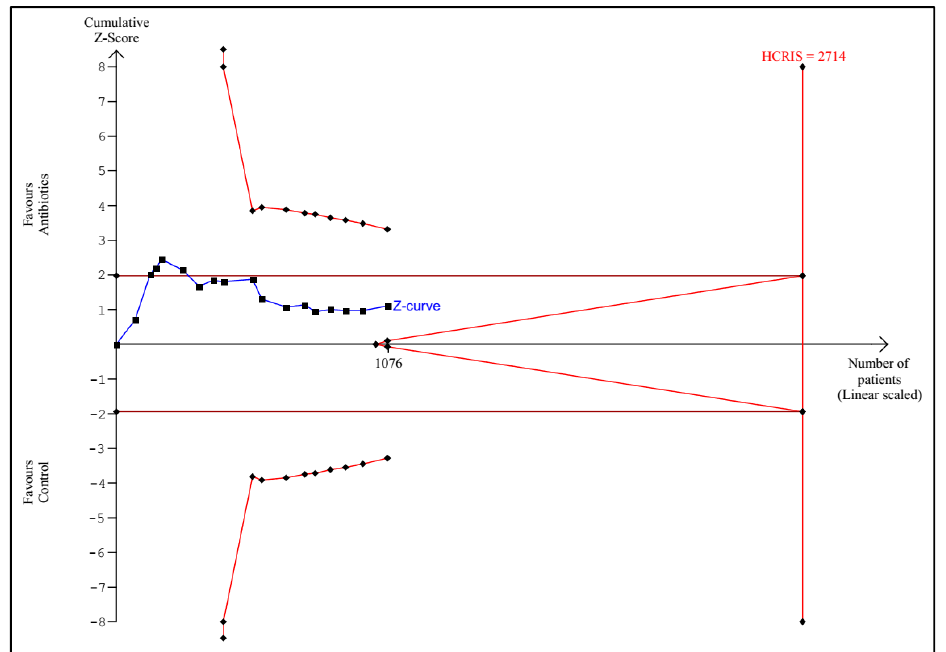
Figure 6. Trial sequential analysis for mortality. The cumulative Z-curve did not cross the conven- tional, nor the monitoring boundaries. The calculated HCRIS is 2714 patients based on an estimated mortality of 10% in the control group, a RRR of 30%, an alpha of 5%, a beta of 20%, and a heterogeneity of 0%. A total of 1076 patients have been randomized (40% of the HCRIS); HCRIS = heterogeneity-corrected required information size.